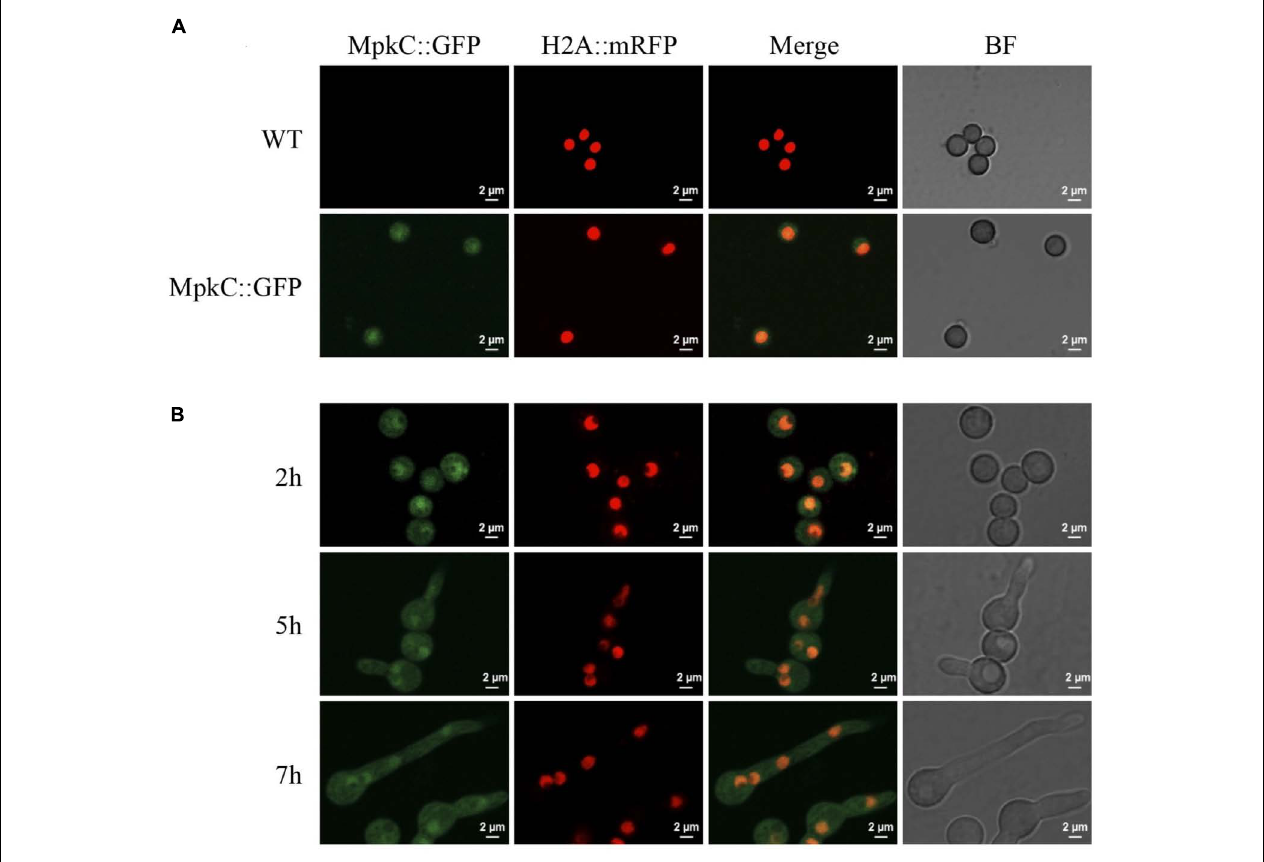
FIGURE 4 | Constitutively expressed MpkC::GFP shows nuclear localization during spore germination, in the absence of stress. (A) Intact conidia from strains TRJ7 (WT H2A::mRFP) and TRJ13 (MpkC::GFP H2A::mRFP) were observed using confocal microscopy. (B) Conidia from strain TRJ13 were germinated for the indicated times and observed using confocal